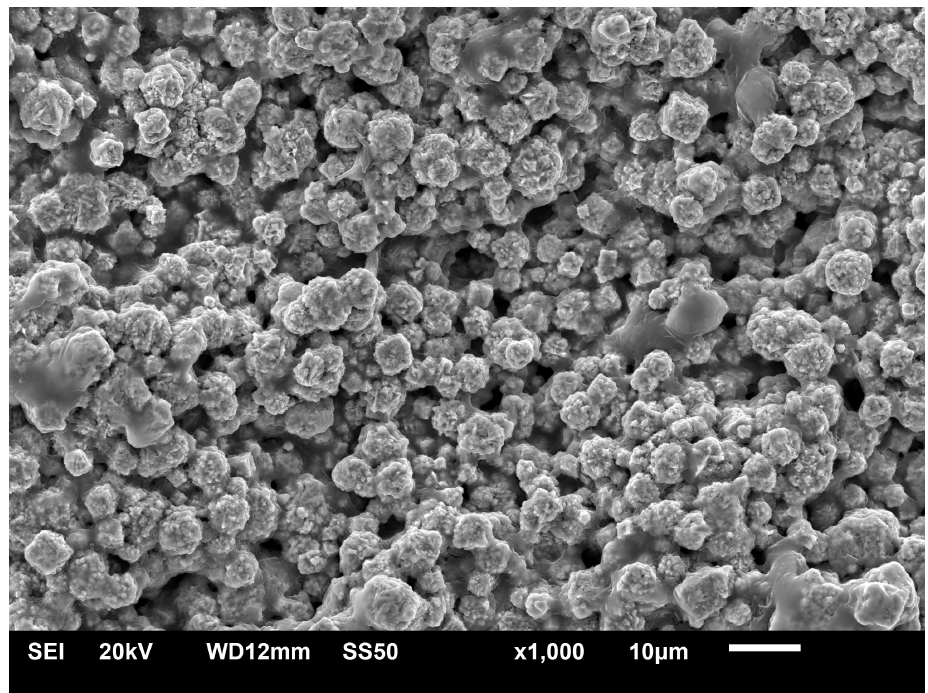
Figure 1. Scanning Electron Micrograph (SEM) image of carbonyl nickel